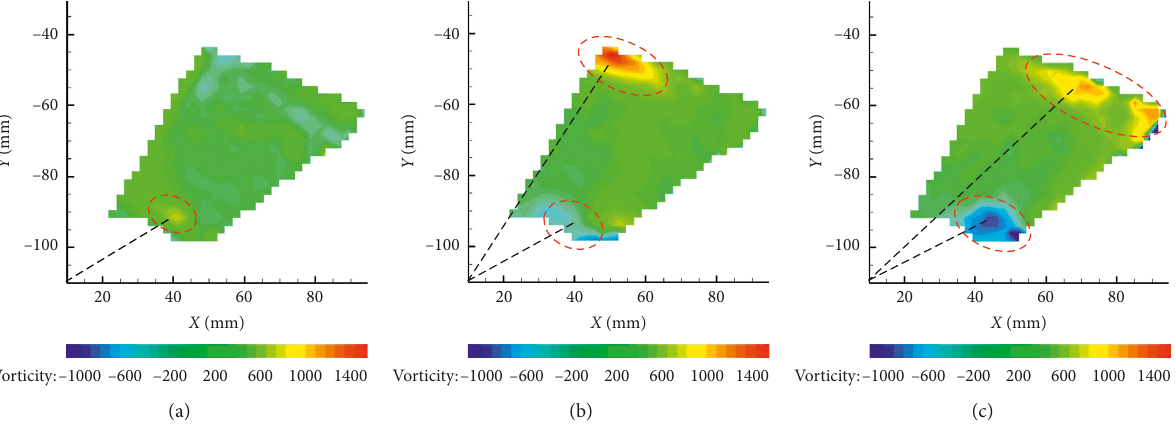
des , (b) 0.4 Q des , and (c) 0.2 Q des